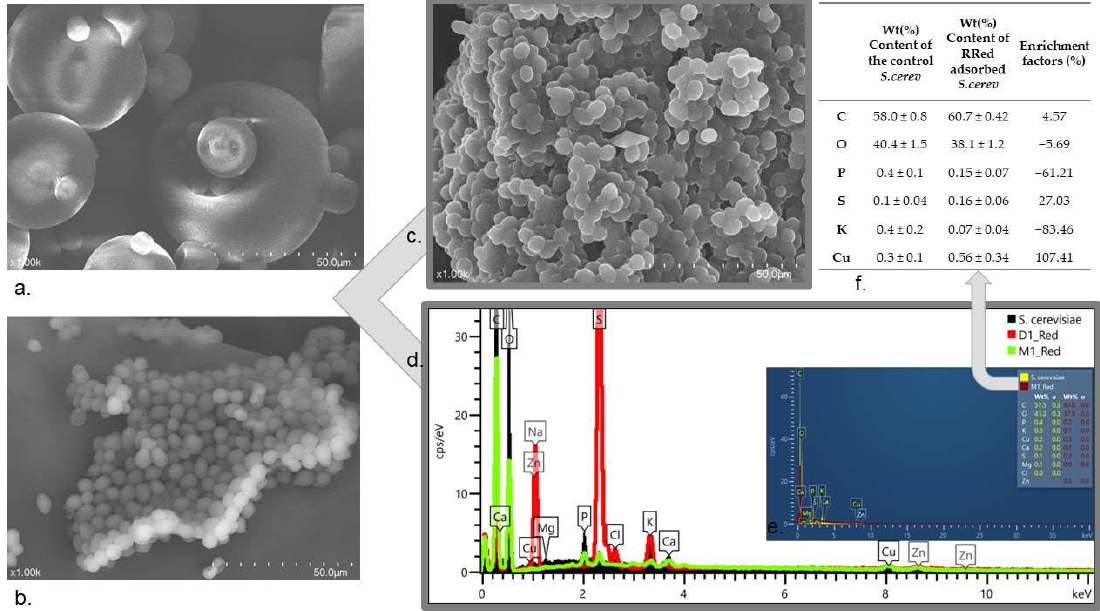
Figure 3 . Adsorbent characterization, with SEM micrographs for ( a ) RR dye, ( b ) control S. cerev., ( c ) 1 g/L RR adsorbed yeast. EDS spectra ( d ) comparison of S. cerev. (black), RR dye (red) and yeast sample after RR adsorption (green). ( e ) Comparison of S. cerev. (yellow) and yeast sample after RR adsorption (red) with numerical values. ( f ) Enrichment factor calculations based on six EDS measurements .